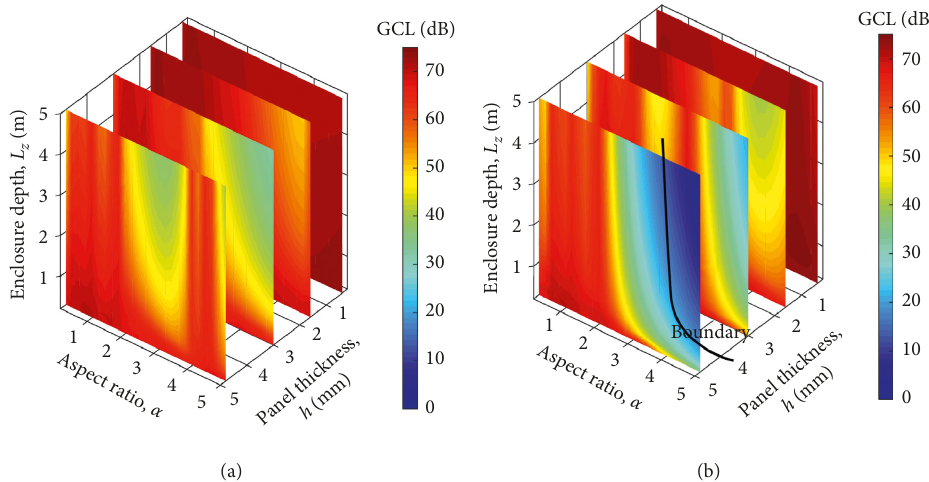
Figure 12: Comprehensive effect of structural parameters on the global coupling level of the coupled system: panel thickness h 1.6mm, 3.0mm, and 4.8mm. (a) Simply supported panel. (b) Clamped